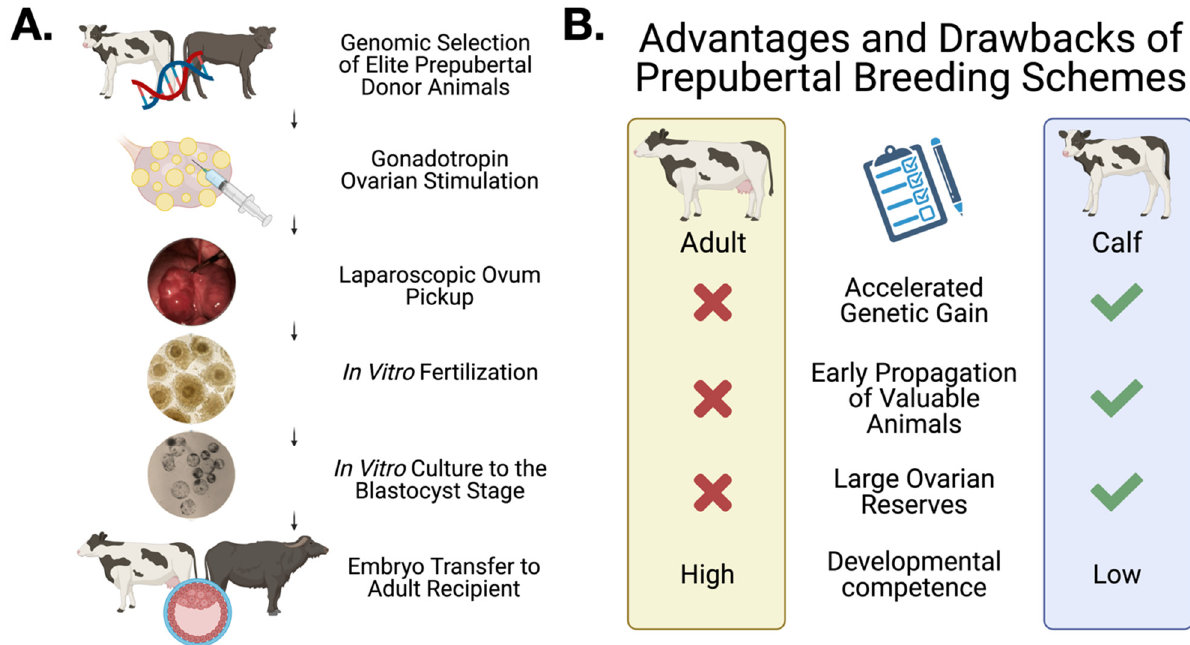
Figure 1. Overview of LOPU-IVEP in Prepubertal Buffalo and Cattle. ( A ): Flow chart showing the typical steps involved in prepubertal LOPU-IVEP programs. ( B ): Comparison between adult and prepubertal breeding schemes, showing the advantages and drawbacks of each. Figure created with BioRender.com, accessed on 30 July 2021.